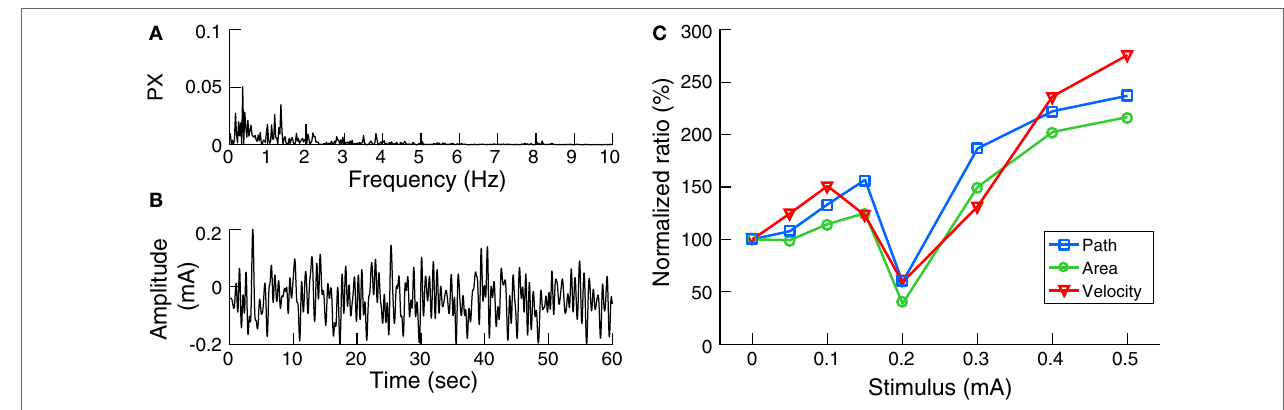
FigUre 1 | Noisy galvanic vestibular stimulation (nGVS) characteristics and effects on postural sway: (a) The power spectrum (PX) of head angular velocity in the medio-lateral axis of an individual subject. (B) Exemplary waveform of nGVS at 0.2 mA intensity. (c) The nGVS balance responses of a sample subject showing lower normalized ratios of the three postural parameters tested at 0.2 mA compared to baseline.